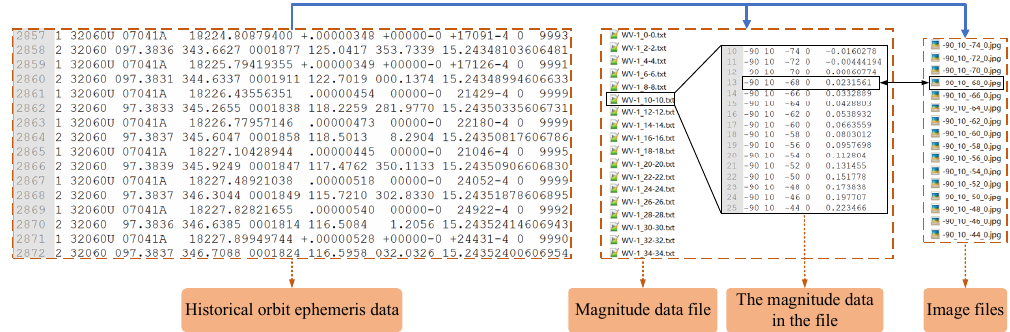
Figure 11. Experimental data. Each magnitude data file includes the magnitude data under different directions of the optical source and detector. Similarly, the image files are the optical images under